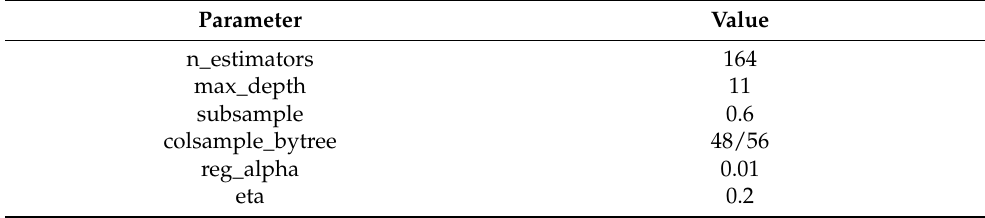
Table 6. The optimized parameters of XGBoost.